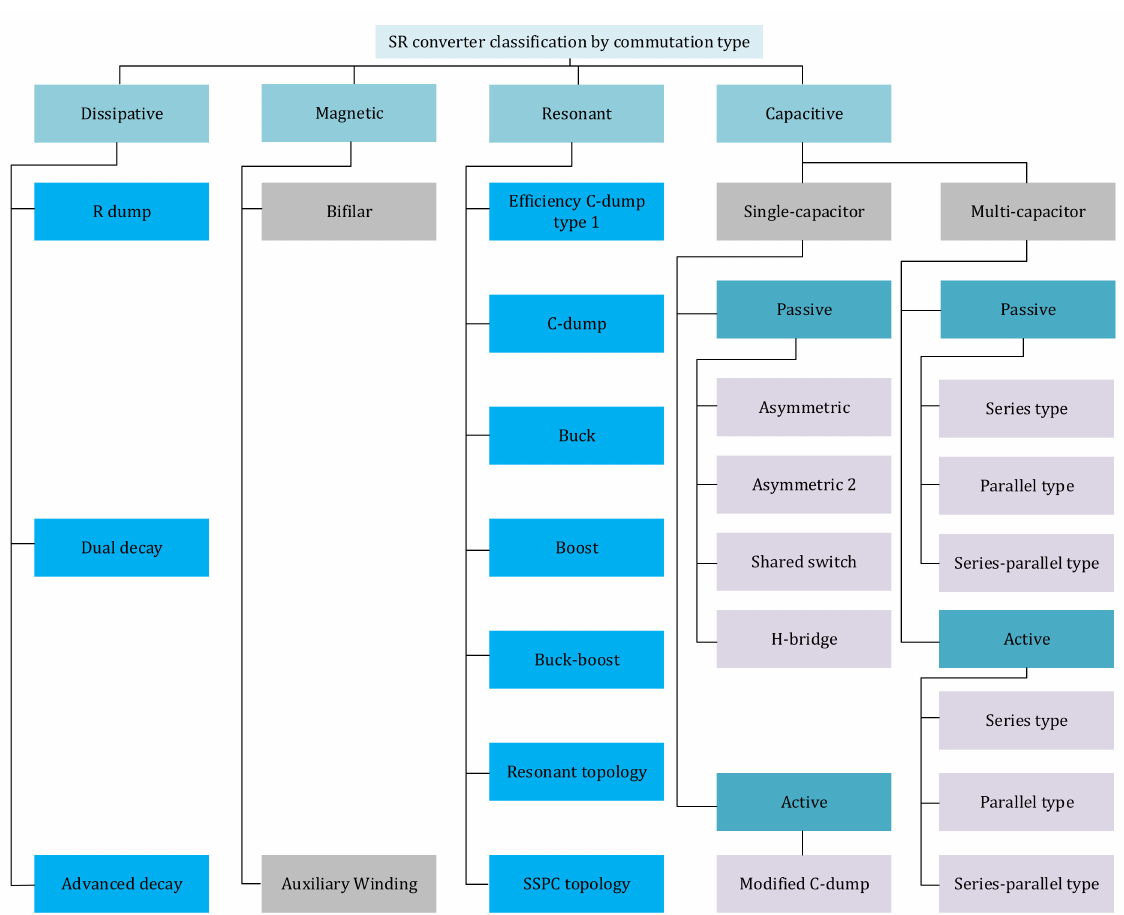
Figure 12. SR converter configuration by commutation type edited from